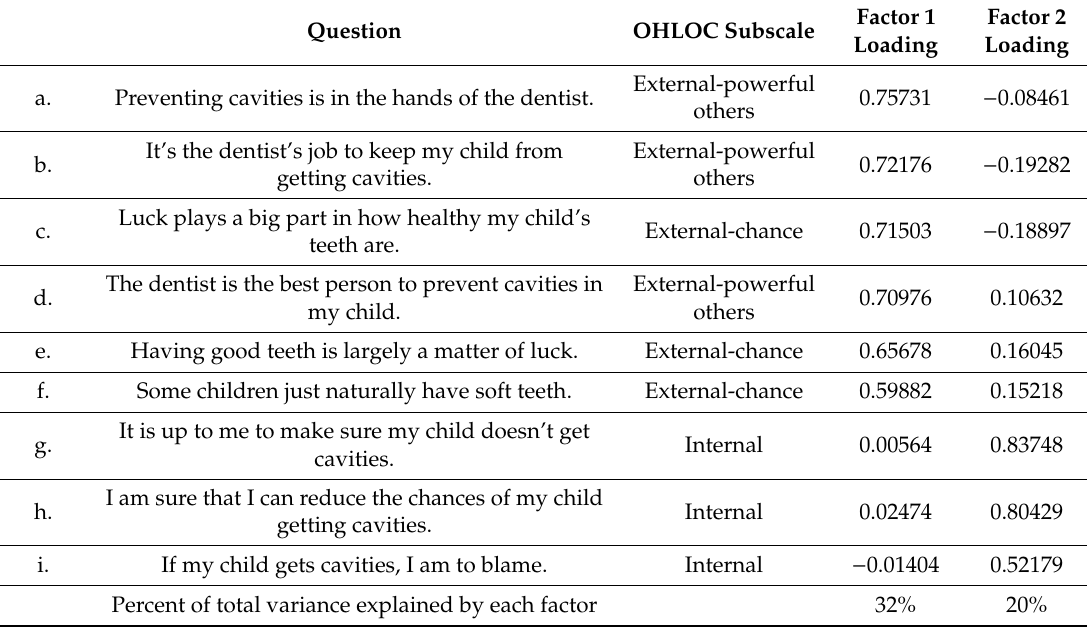
Table 1. Exploratory factor analysis after varimax rotation (N =